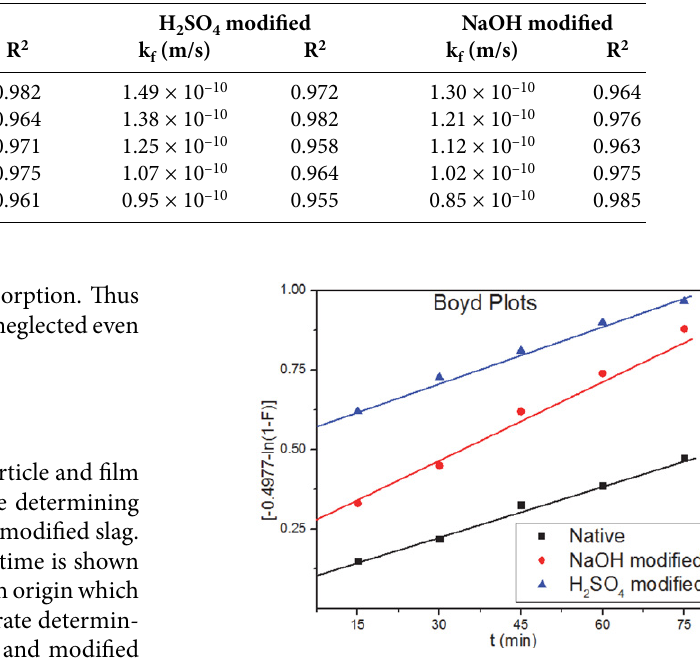
Figure 7. Boyd Mass plots for As(III) adsorption using native and chemically modified brick kiln